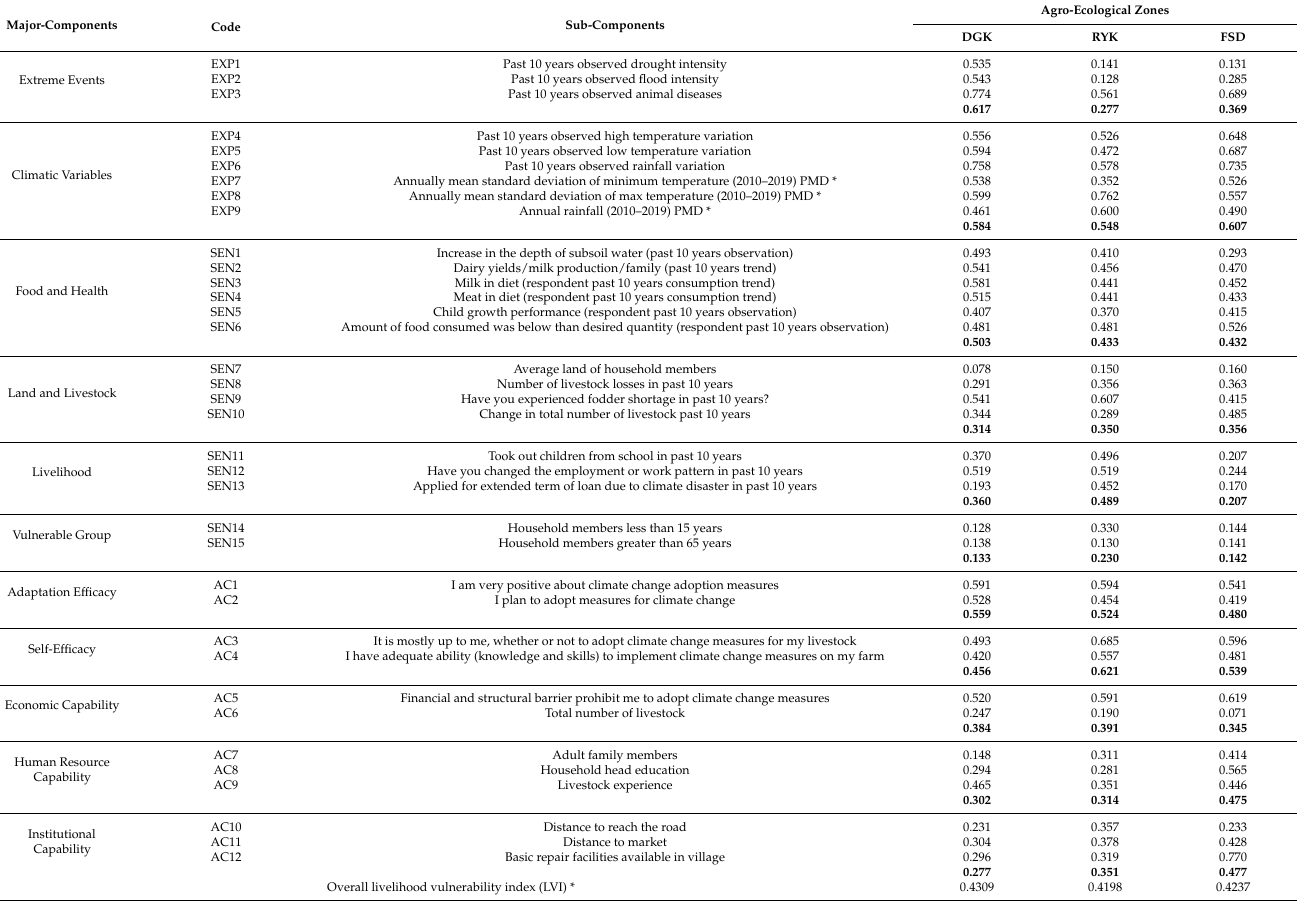
Table 5. Indexed sub-components and overall livelihood vulnerability index